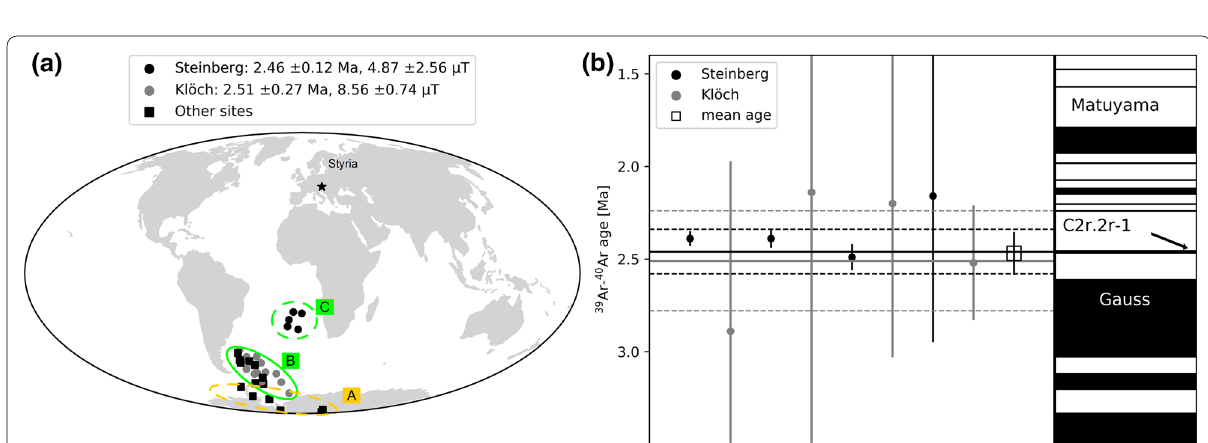
Fig. 13 a Clusters of virtual geomagnetic poles from Styria. b 39 Ar/ 40 Ar-ages with 2 sigma errors from individual samples are shown together with their weighted mean and error band in comparison with the geomagnetic instability time scale (Singer 2014; Ogg et al.